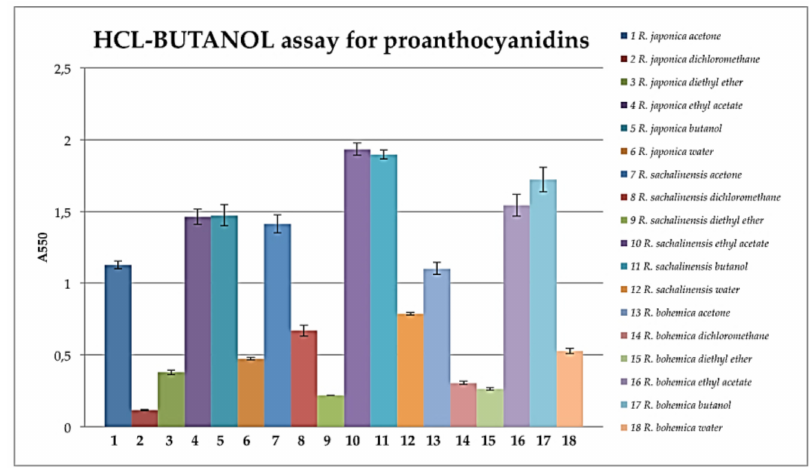
Figure 8. Proanthocyanidins quantified spectrometrically by absorbance at 550 nm in extracts and fractions. Data were expressed as mean ± SD, performed in at least three independent experiments, assayed in triplicate.